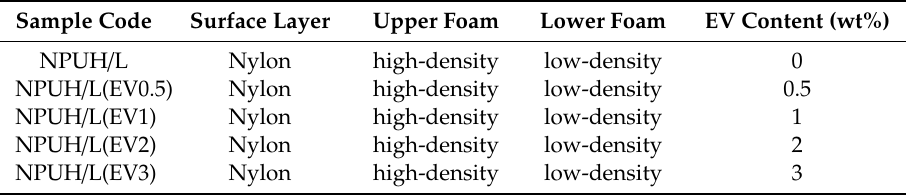
Table 1. Specifications of bionic